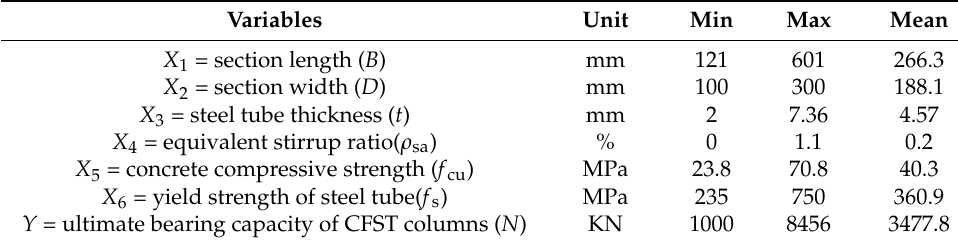
Table 2. The details for geometrical factors of specimens.